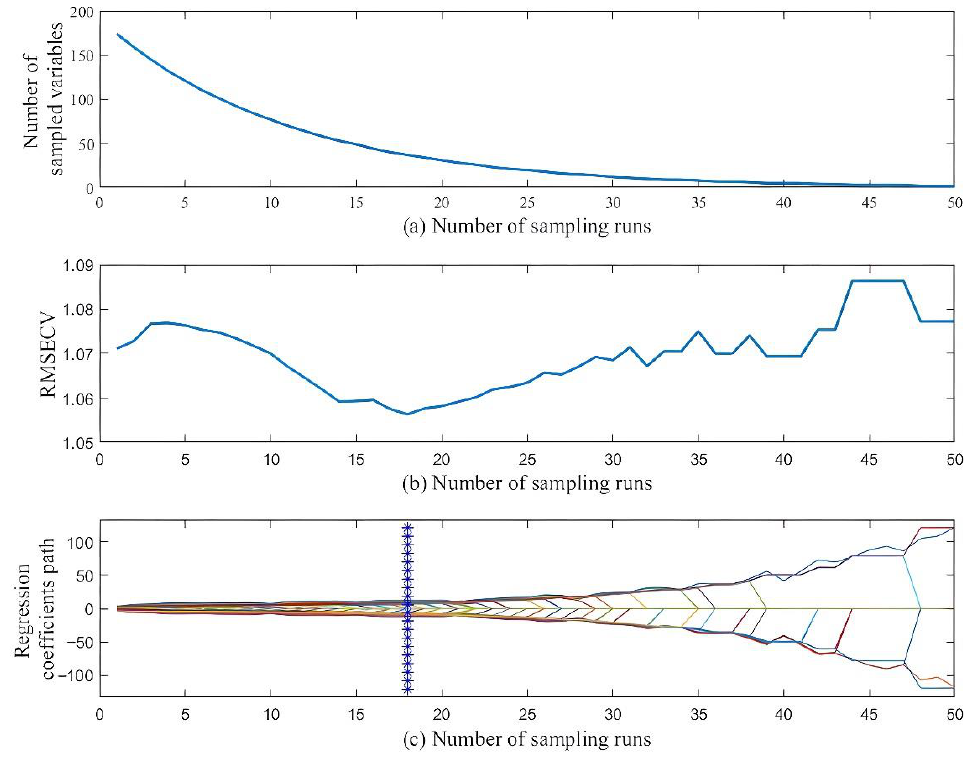
Figure 5. Selection results of CARS for EEMD-db3 denoised first-order derivations: ( a ) Trend of the number of selected wavelengths; ( b ) Trend of RMSECV; ( c ) Trend of regression coefficients of each wavelength.